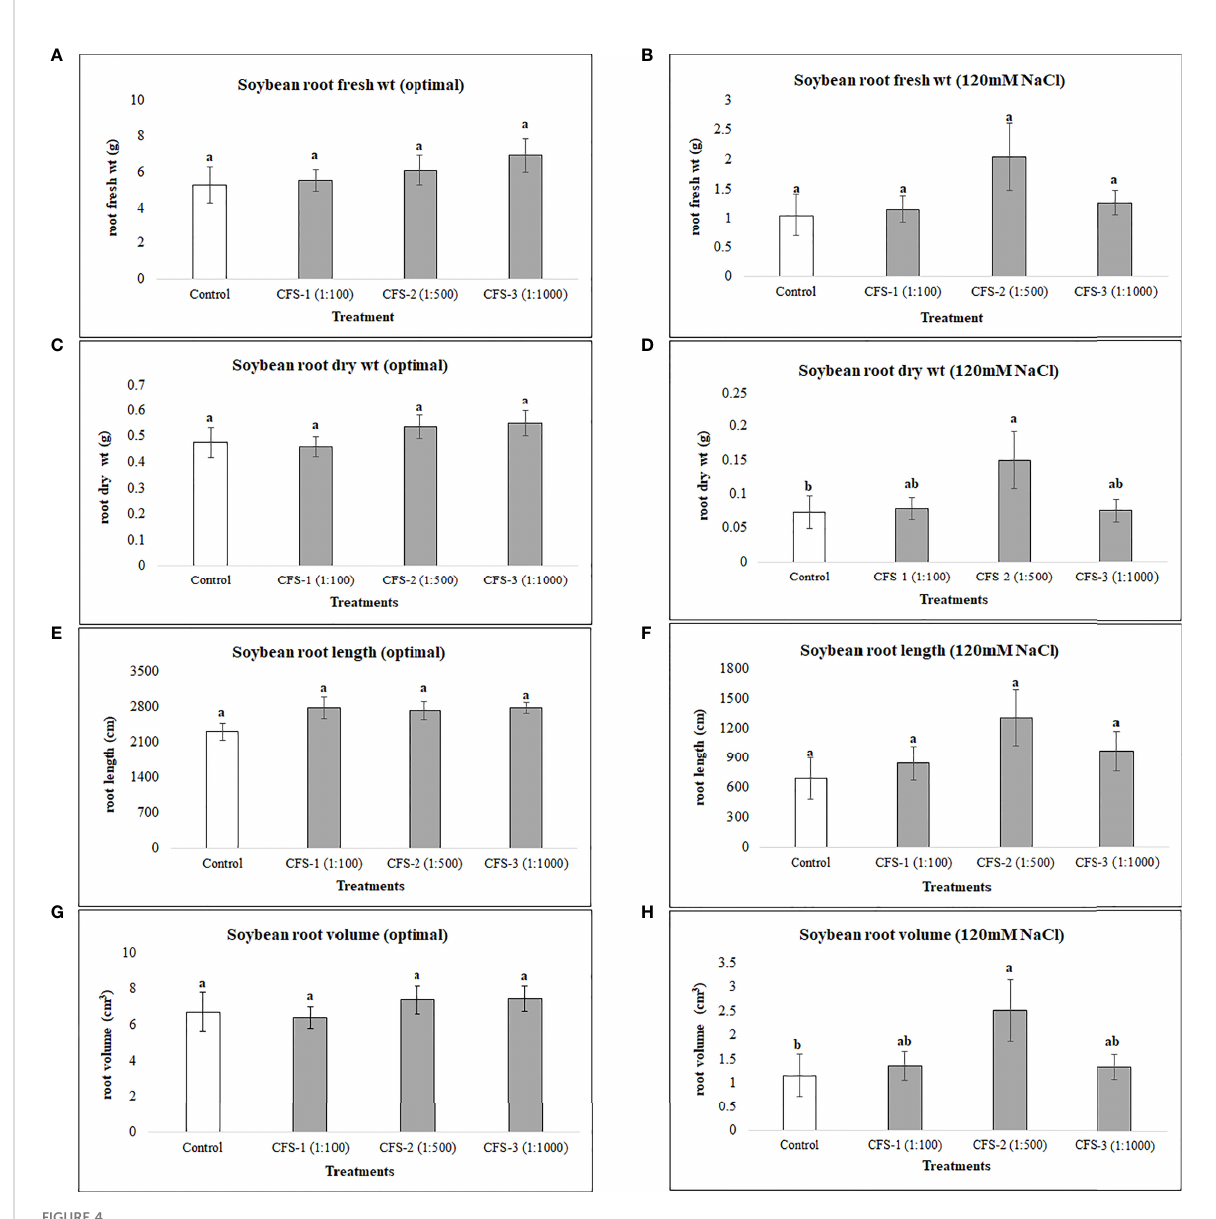
FIGURE 4 Soybean root variables affected by CFS (A) root fresh wt - optimal (B) root fresh wt – 120 mM NaCl (C) root dry wt - optimal (D) root dry wt – 120 mM NaCl (E) root length - optimal (F) root length – 120 mM NaCl (G) root volume - optimal (H) root volume – 120 mM NaCl. The data represents the mean values of 8 replications (n=8) ± standard error. Different letters indicate values determined by Tukey ’ s multiple mean comparison to be signi fi cantly different (p< 0.05) from each